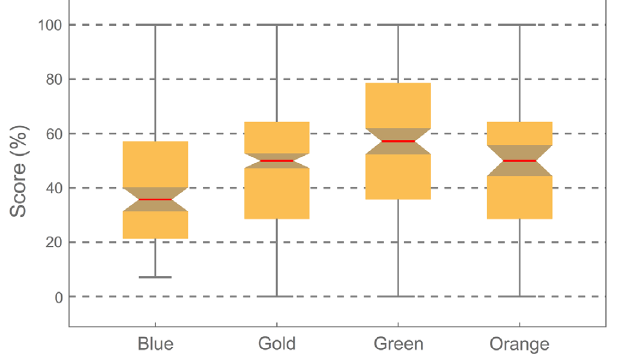
FIG. 4. Precourse FCI scores for different personality types.